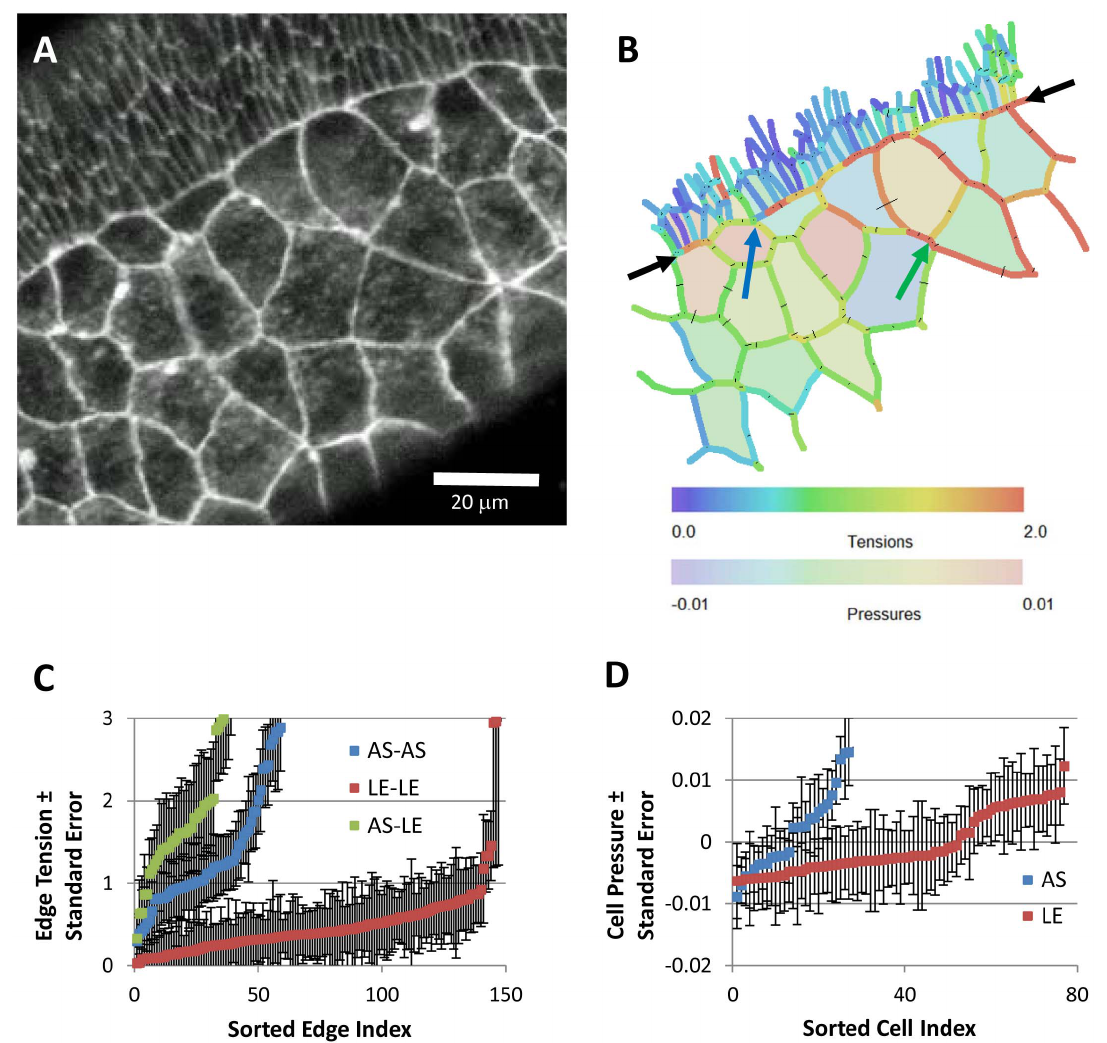
Figure 5. CellFIT analysis of cells near the amnioserosa/lateral epidermis boundary during early dorsal closure in a living Drosophila embryo, as imaged in (A) and with inferred Standard Tensions and Pressures illustrated in (B) according to the color bars. The amnioserosa is visible in a wide band from the lower left-hand corner towards the upper right, while the lateral epidermis, identifiable by its smaller cells, is confined to a large triangle in the upper left corner. The boundary between these two tissues is indicated by the black arrows. The blue and green arrows point to features discussed in the text. Overall, the CellFIT equations were very well conditioned – having tension and pressure condition numbers of 30.3 and 15.6, respectively. The tension and pressure residuals are shown in (B) as thin lines emanating from each triple junction and bisecting each cell edge, respectively. These residuals are scaled so that a residual equal to the mean tension has a length equal to the mean cell radius. Even at this scaling, the residuals are generally quite small and many are barely discernable. Finally, confidence limits are shown for individual tensions and pressures, (C) and (D) respectively, by boundary type. The points and bars indicate best estimate + / 2 one standard error (based on the covariance matrix), respectively. These confidence limits are a significant, but modest, fraction of the inferred tensions and pressures. Prior investigations have suggested the existence of a uniform high-tension purse-string along the edge of the amnioserosa, but CellFIT reveals a more complex and interesting scenario. See text for